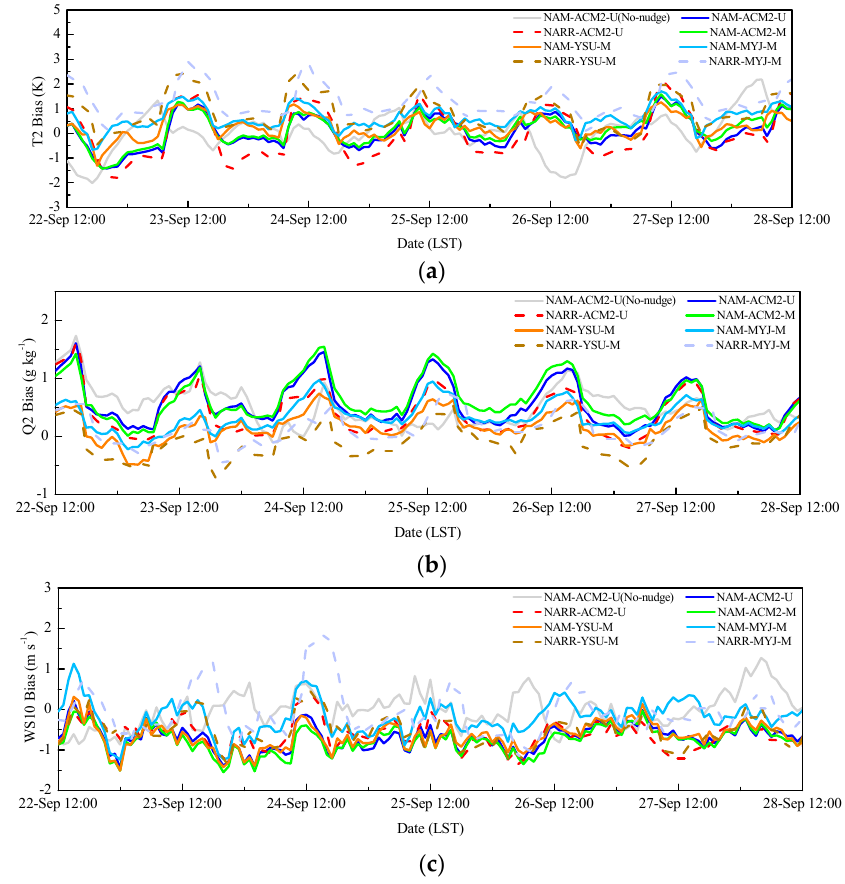
Figure 2. Hourly time variation of ( a ) 2-m temperature (T2) bias, ( b ) 2-m water vapor mixing ratio (Q2), and ( c ) 10-m wind speed (WS10) averaged over the 72 sites compared with surface TDL